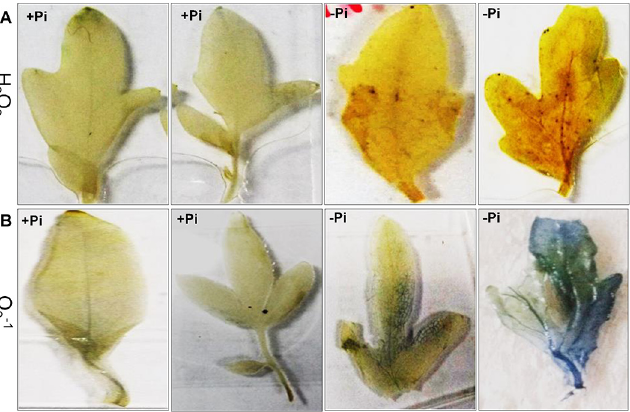
Fig 2. Histochemical localization in leaves of tomato ( Solanum lycopersicum L.) to Pi starvation. One week after germination tomato plants were supplied with sufficient Pi (1 M KH 2 PO 4 ) or deficient Pi (0 M KH 2 PO 4 ) for 10 days. (A) H 2 O 2 by DAB staining (B) O 2-1 by NBT staining, dark brownish parts indicate localization of H 2 O 2 and blue parts indicate localization of O 2-1